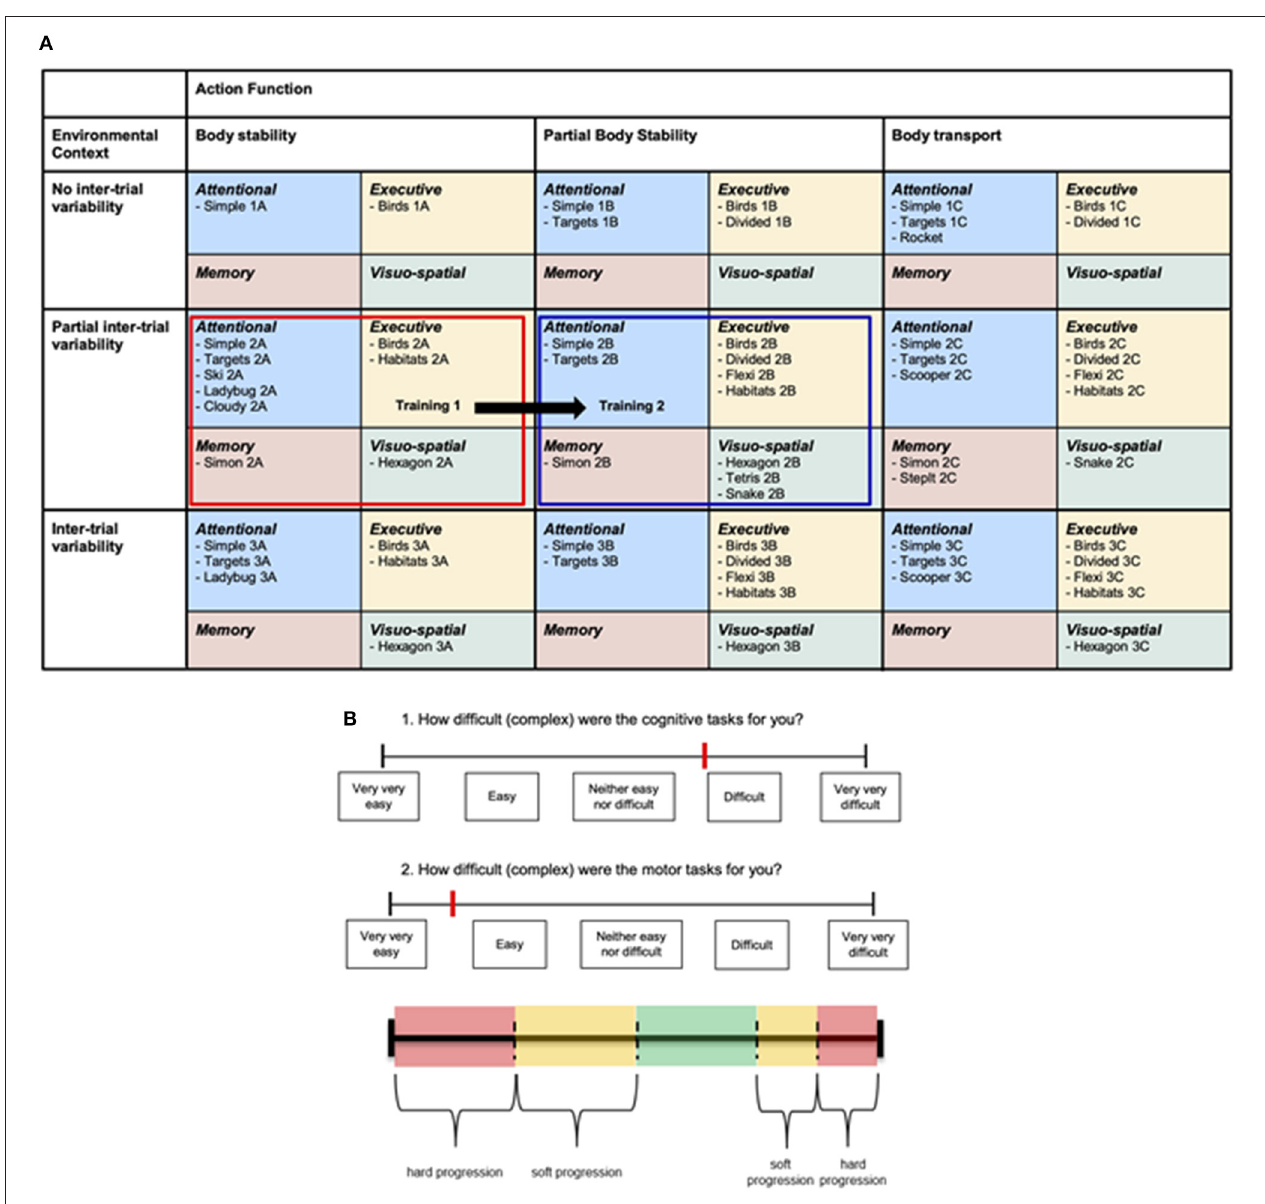
FIGURE 3 | (A) The final adapted taxonomy and two “position squares” of a first and second training. (B) Visual analog scale, which were used to rate perceived motor and cognitive task difficulty after each training session, and the scale indicating the ranges for no (green), soft (yellow), and hard (red) progression. Two possible rating locations are indicated (red lines), which would lead to the shift of the red “position square” of the first training to the green “position square” for the second training in (A)